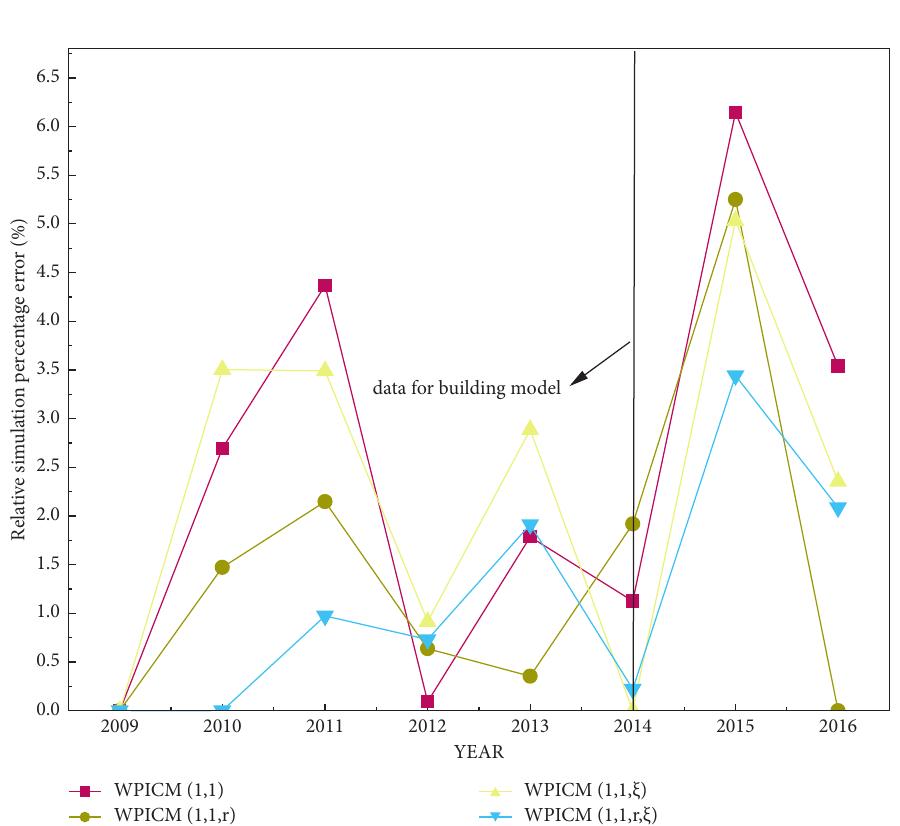
Figure 7: RSPE of model’s